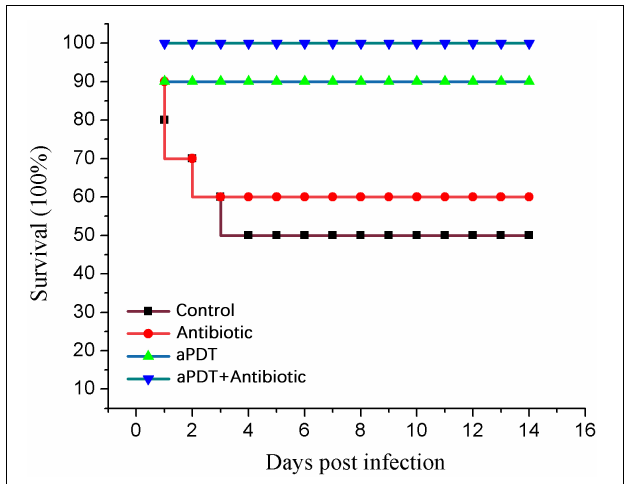
FIGURE 9 | Survival of treated and untreated rats.